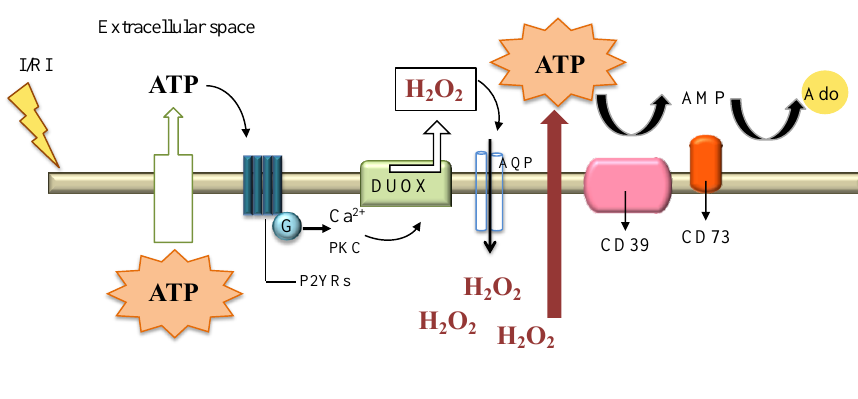
Figure 4. Ischemia reperfusion injury (I/RI) induces the passive or active release of intracellular ATP to the extracellular space. Once in the extracellular milieu, ATP can activate G-protein-coupled receptors (P2YRs) to stimulate calcium-dependent signaling and the activation of protein kinase C (PKC) allowing the activation of the DUOX complex and the release of H 2 O 2 . H 2 O 2 can cross the cellular membrane via AQP to initiate redox signaling and further promote ATP efflux. Extracellular ATP is metabolized by enzymatic phosphohydrolysis in a two-step process via CD39 conversion of ATP to AMP, and CD73 phosphohydrolysis of AMP to adenosine (Ado). The latter, can mediate anti-inflammatory effects [50,79,84,85].